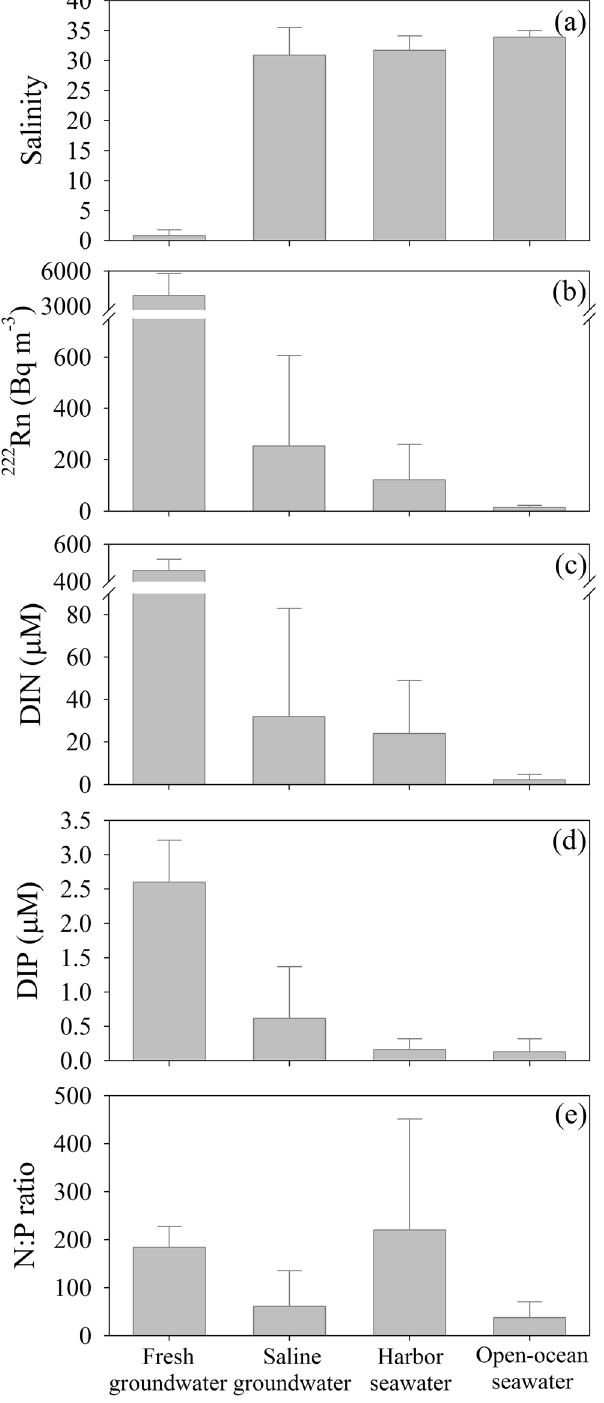
Figure 2. The averages and standard deviations of ( a ) salinity, ( b ) 222 Rn, ( c ) DIN, ( d ) DIP concentrations, and ( e ) N:P ratios in fresh groundwater, saline groundwater, harbor seawater, and open-ocean seawater from July 2015 to March 2016 in Jocheon, Jeju Island. The error bars are the standard deviation of each data